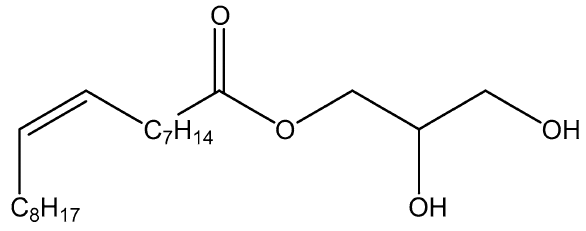
Figure 1. The molecular structure of glycerol monooleate